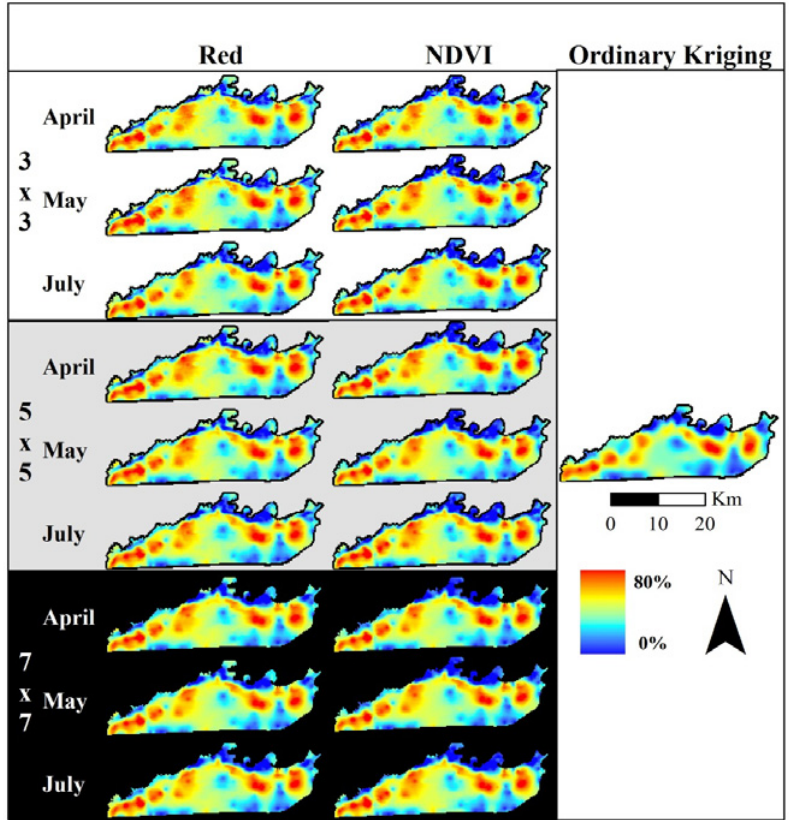
Figure 6. Percent elephant utilization interpolated across the Chobe riverfront using universal kriging with the Moving Standard Deviation Index (MSDI) as the explanatory variable and ordinary kriging considering only vegetation plot data. The white, grey, and black sections indicate the three window sizes used for MSDI calculations while rows within sections indicate the imagery dates. The ordinary kriging prediction is only based on field data and does not conform to any particular date. Results for the near-infrared band and the SAVI and MSAVI2 indices were highly similar and are presented in the Supplementary Materials, Figure